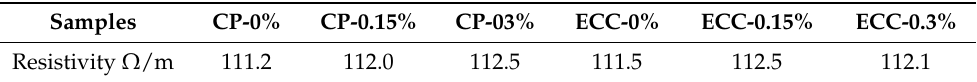
Table 4. Ohmic resistance of the extra resistor ( R 0 ).